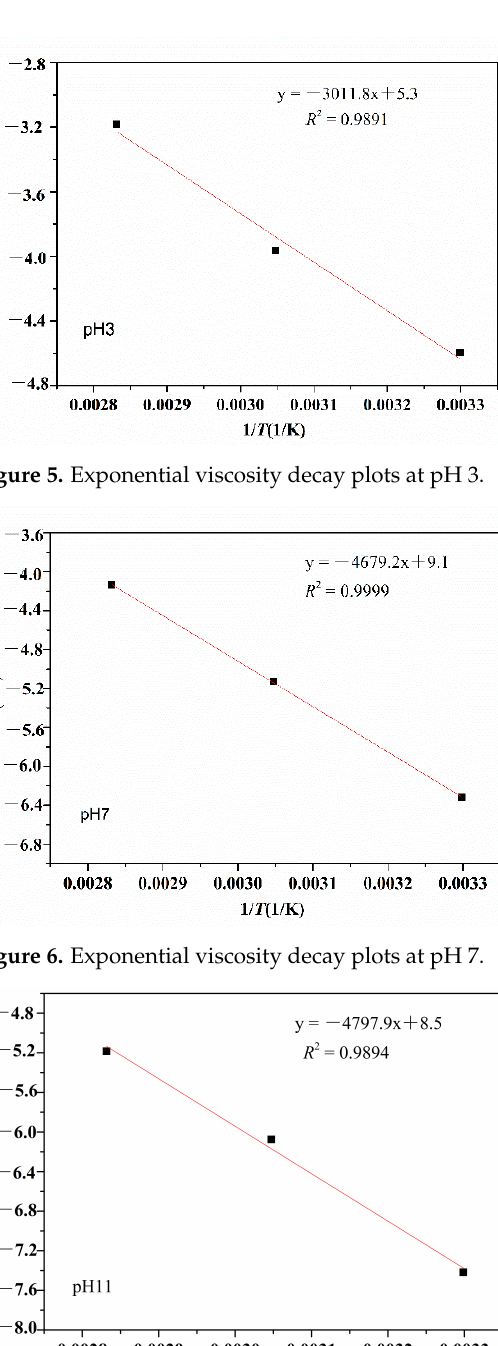
Figure 7. Exponential viscosity decay plots at pH 11.